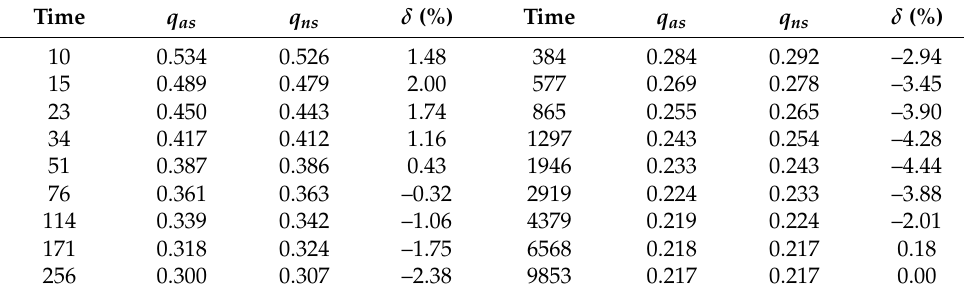
Table 2. Comparison of calculated results under stable boundary.